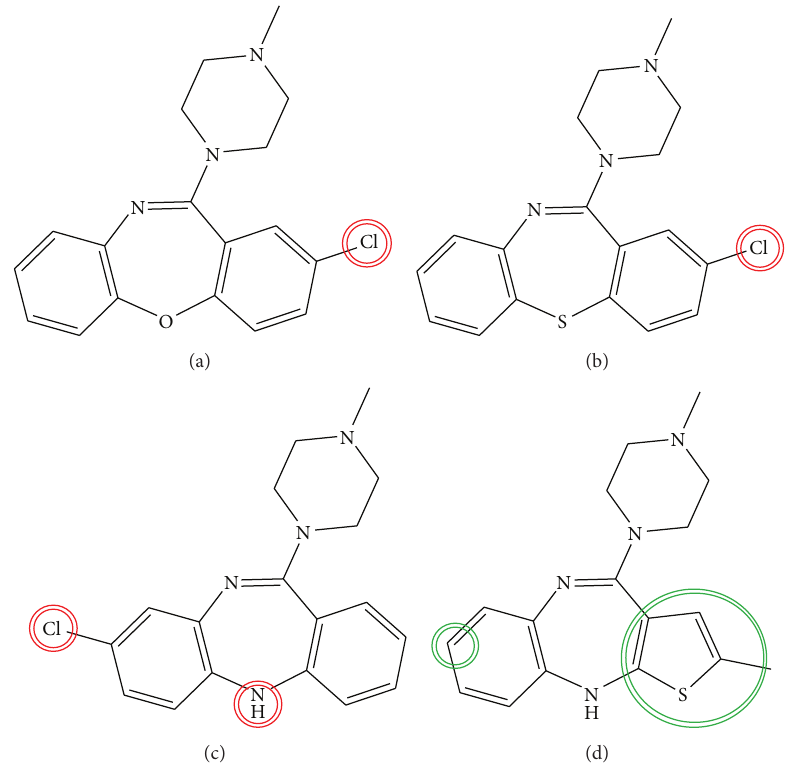
Figure 1: Limitations of current antipsychotic therapies (a) loxapine; (b) clothiapine; (c) clozapine; (d)